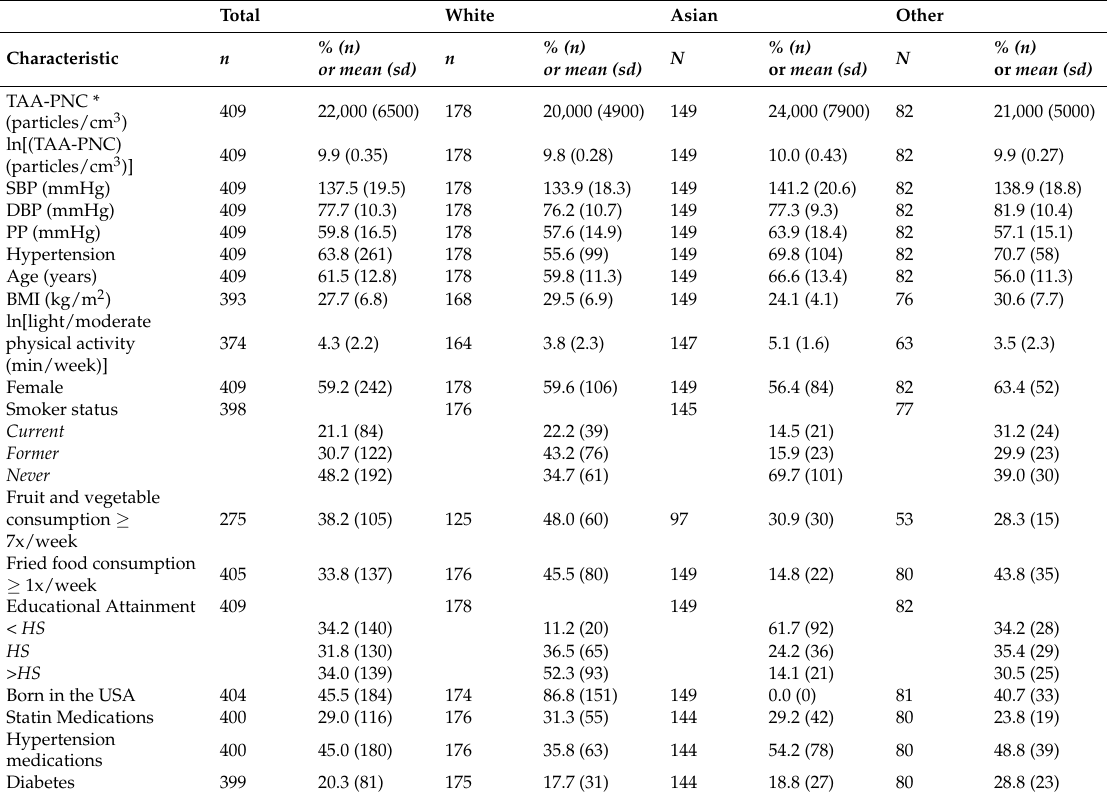
Table 1. Study sample